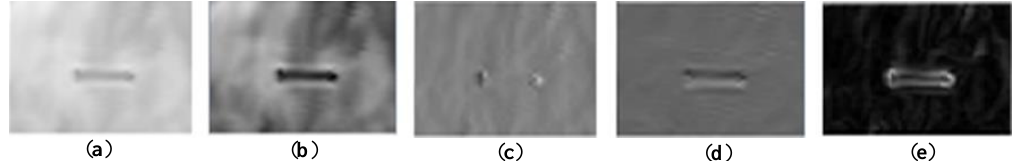
Figure 20. Images of notch 1 under the 2 mm-thick rubber layer obtained at a standoff distance of 0.1 mm: ( a ) original and after ( b ) average filtering, ( c ) gradient filtering in the x-direction ( G x ) , ( d ) gradient filtering in the y-direction ( G y ) and ( e ) gradient magnitude with the Sobel method, |G| = √G x2 + G y2 .